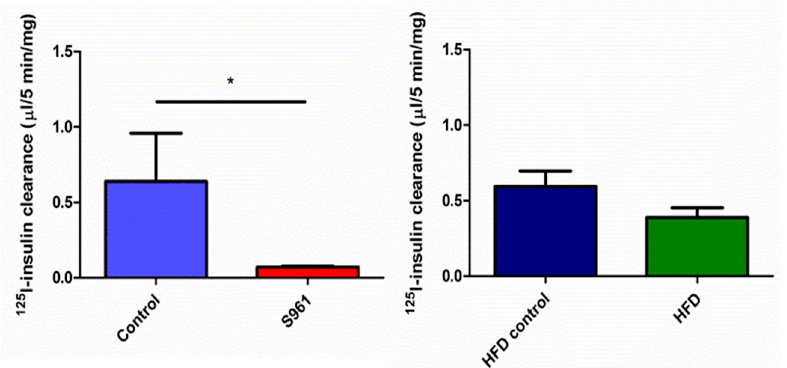
Figure 4. Liver radiolabeled insulin clearance in rats studied under protocol 1 (left panel) or protocol 2 (right panel). S961 significantly decreased radiolabeled insulin uptake (*; p = 0.01), while high-fat diet provoked a downward trend in hepatic insulin clearance ( p = 0.056).